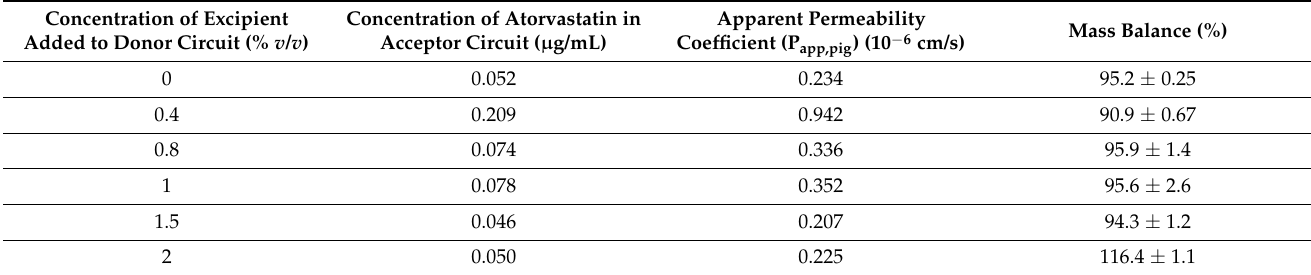
Table 1. The apparent permeability coefficient values for the passive absorption of Atorvastatin through ex vivo porcine tissue from a series of drug absorption experiments conducted using the modified QV600 LLI system in the presence of increasing amounts of the solubilizing agent polysorbate 80. (With corresponding mass balance